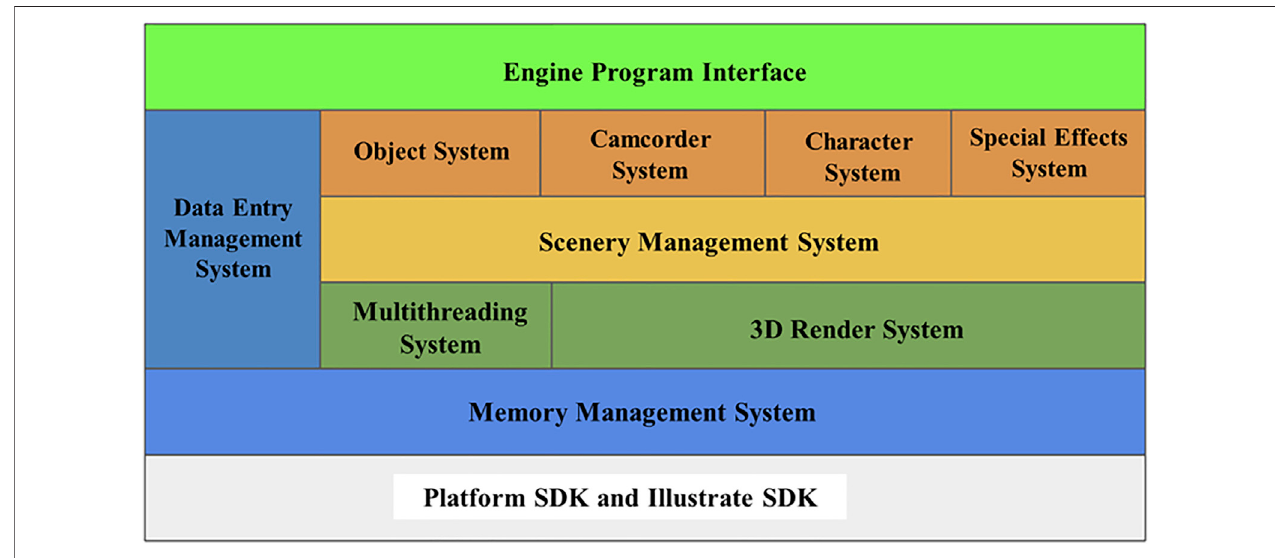
FIGURE 10 | Framework of the developed system ’ s program engine.